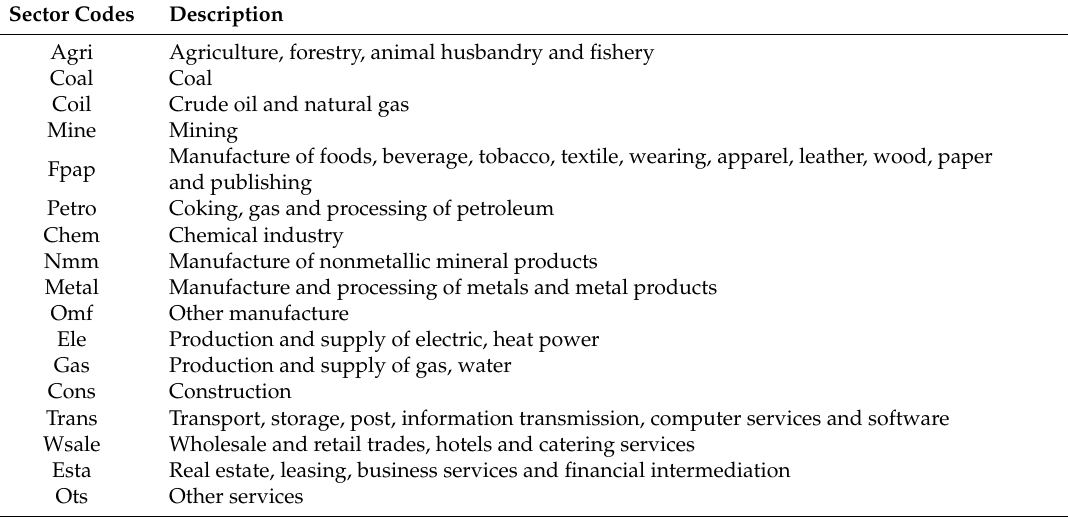
Table 1. Sector declarations and